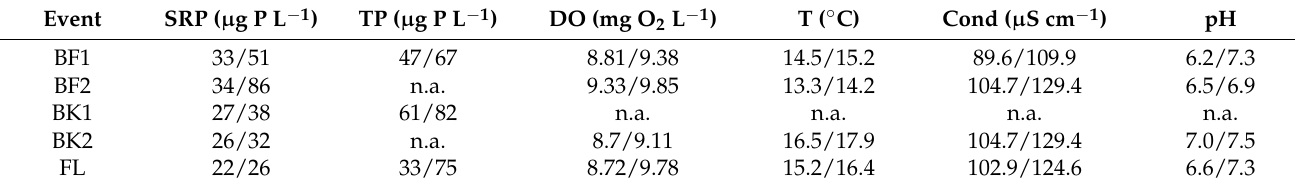
Table 3. Water quality values at the sampling dates. Numbers represent the variation range (min/max, n = 4). Refer to Table 1 for the description of the